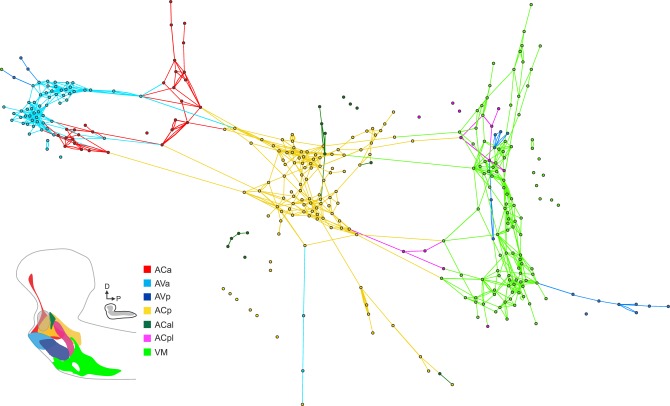
Map of inter-sensory connections.Force-directed connectivity graph of all axo-axonic connections between sensory neurons. Each node represents a single neuron. Nodes are colored based on their broader identity (sensory compartments).